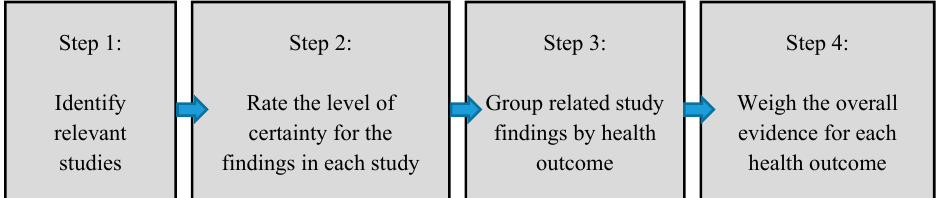
Figure 1. Steps in the current systematic review of epidemiologic literature .